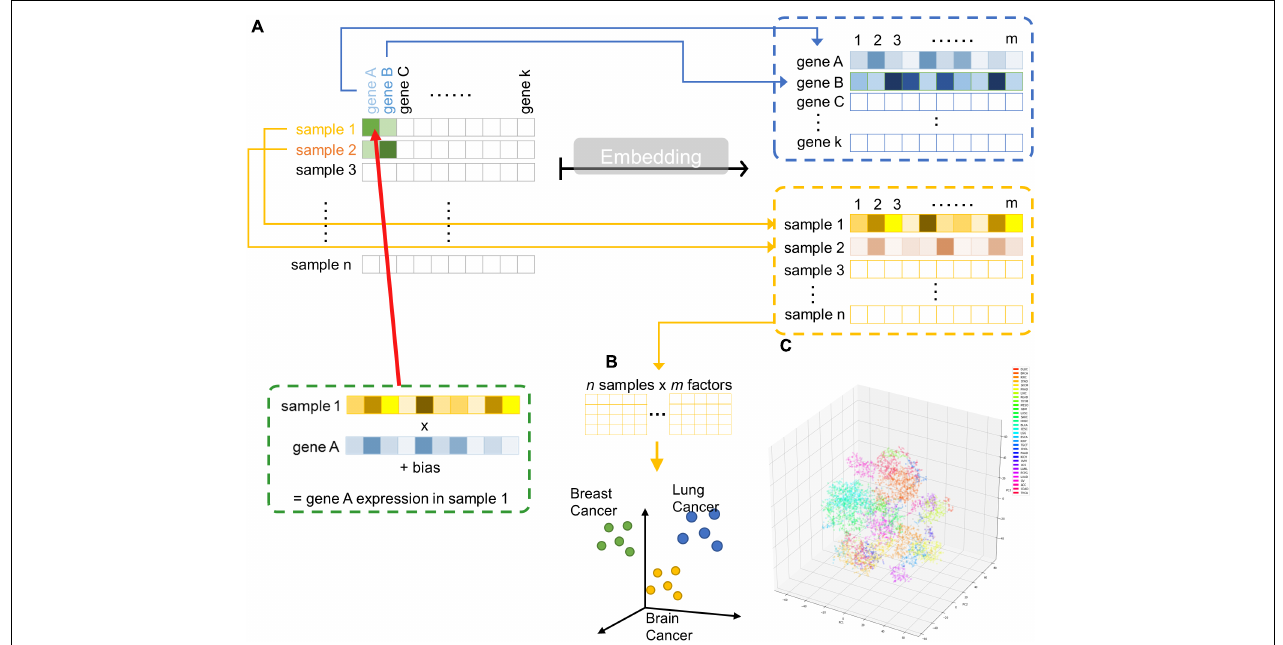
FIGURE 1 | Overview of embedding system from a large gene expression dataset. (A) Schematic representation of entity system. Input data is a matrix of n samples (rows) × k genes (columns) with gene expression encoded in each cell. Through embedding, categorical variables, i.e., genes and samples, were represented as m -dimensional vector. (B) Samples are projected into m dimensional sample entity vector space. The embedding system learnt the feature of sample solely from input matrix, such that similar sample are clustered in close proximity. (C) t-SNE representation of sample entity matrix from whole TCGA RNASeqV2 dataset. 32 cancer types are labeled with different color.